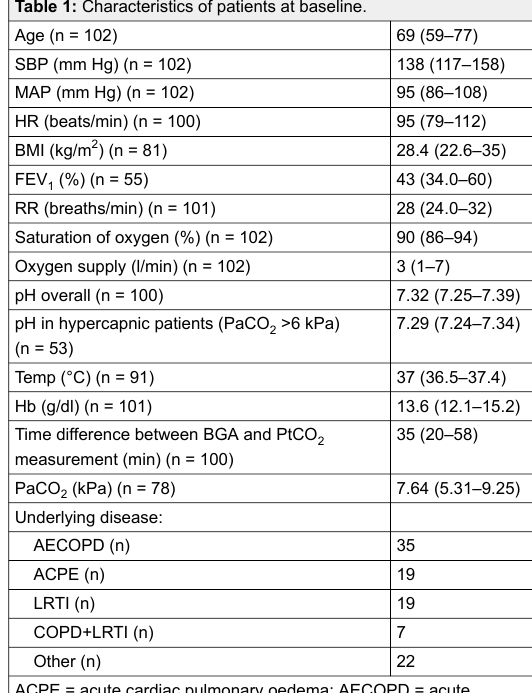
Figure 2 Real-time PtCO 2 monitoring of two patients undergoing noninvasive ventilation. (A) Exacerbated chronic obstructive pulmonary disease, (B) Acute cardiac pulmonary oedema. The red cross indicates the PaCO 2 values from the arterial blood gas analysis, PtCO 2 values (dashed lines) and SpO 2 values (solid lines) are demonstrated. ABGA = arterial blood gas analysis; PaCO 2 = arterial partial pressure of CO 2 ; SpO 2 = oxygen saturation